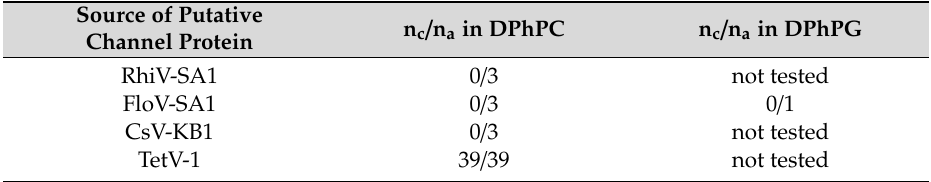
Table 2. Ratio of measurements with channel activity (n c ) divided by the number of attempts